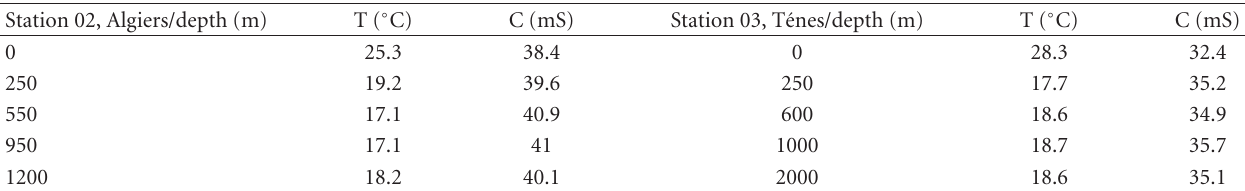
Table 1: Measurement of T ( ◦ C) and C (mS) parameters at stations 02 and 03, Algiers and T´enes sampling campaign. (08 to 23 August 2001.)